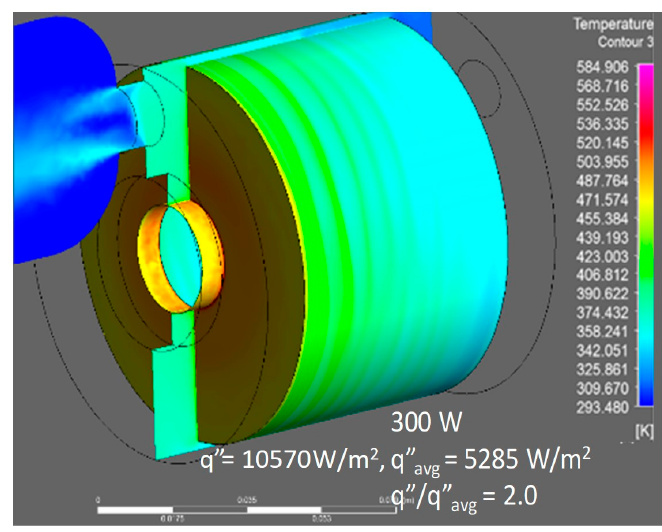
Figure 23. Isotherms for rotor parasitic heat flux q ” = 10,570 W/m 2 .